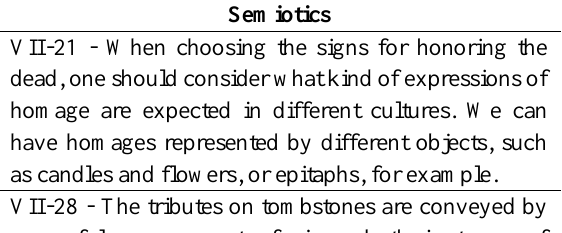
Table 4. Semiotics. (Conclusion)